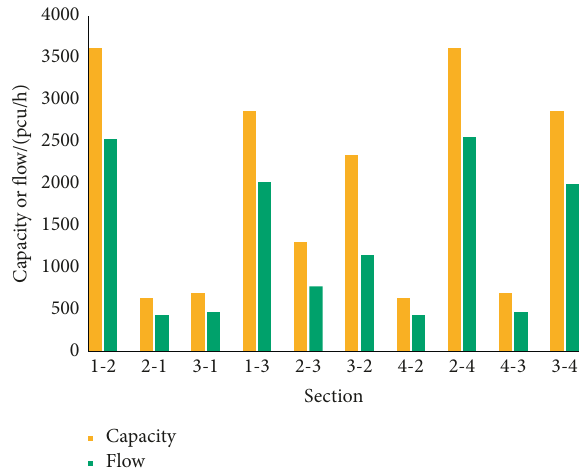
Figure 4: The capacity and flow of each section after reversible lane optimization. Table 3. For comparison, the capacity and flow of each section before reversible lane optimization are shown in Figure 3. The capacity and flow of each section after re- versible lane optimization are shown in Figure 4. The